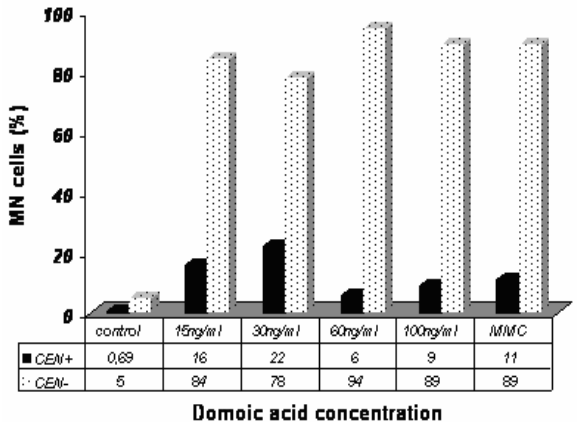
Figure 5: FISH analysis in Caco-2 cells after 24h exposure to DA. MN= number of micronucleated cells; CEN+= MN containing one or more centromeric signals (percentage); CEN-= MN without a centromeric signal (percentage); MMC= Mytomicin C